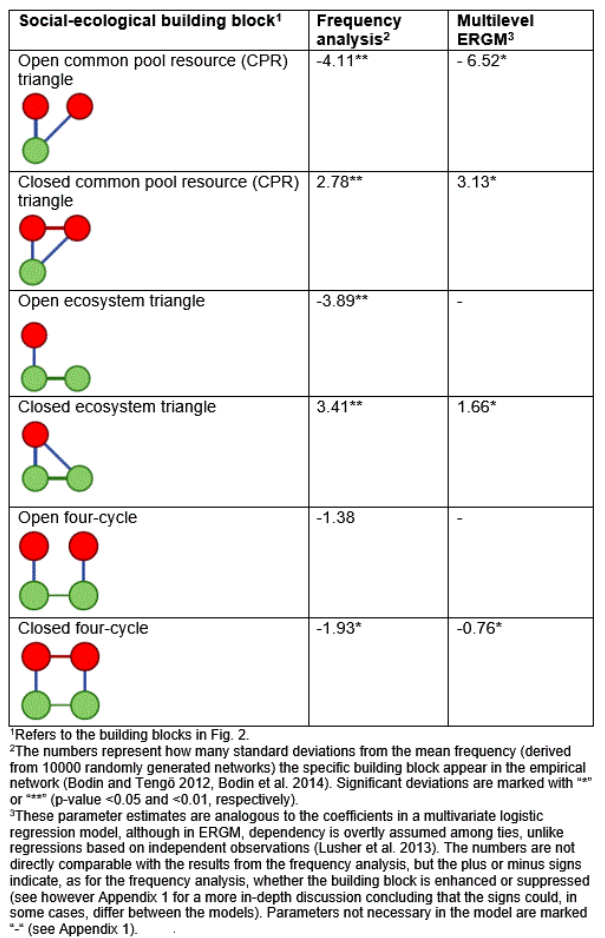
Fig. 4 . Results from the frequency analysis and the multilevel exponential random graph models